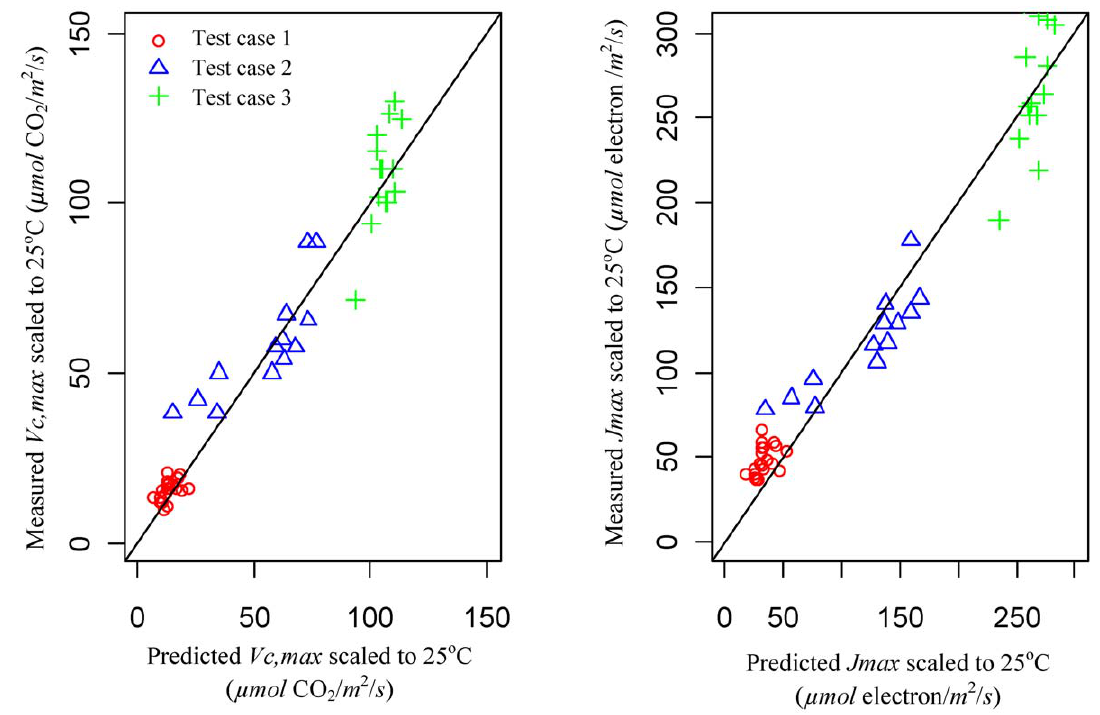
Figure 3. Nitrogen allocation model evaluations. The figure shows the scatter plots of predicted and measured V c,max and J max scaled to 25 u C (i.e., V c,max25 and J max25 ) at elevated CO 2 (570 ppm , test case one), reduced radiation in canopy (0.1–0.9 of the radiation at the top of canopy, test case two) and reduced growing temperature (15 u C, test case three). The model is first calibrated using control data under ambient CO 2 (370 ppm), radiation at the top of the canopy (621 m mol photon/ m 2 /s ), the normal growing temperature (30 u C). The fitted model is then used to predict V c,max25 and J max25 under altered environments.